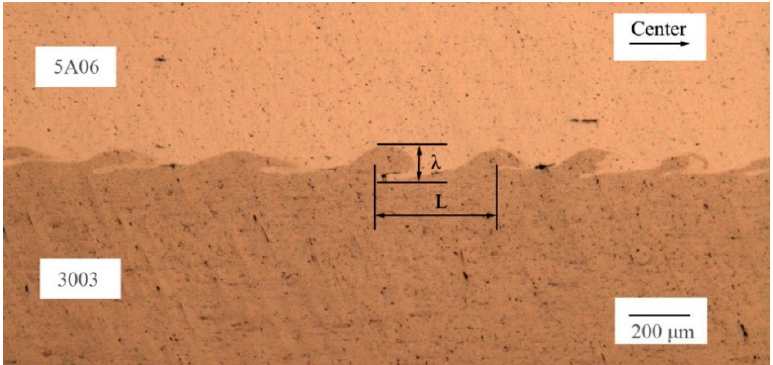
Figure 8. Interface morphologies of wave bonding area with 6 kJ energy input.